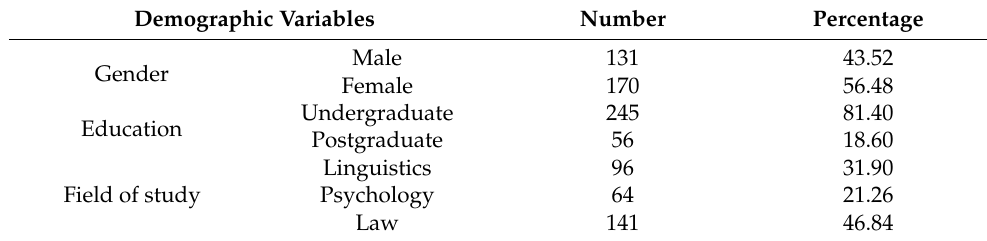
Table 1. Demographic profile of respondents (N = 301).